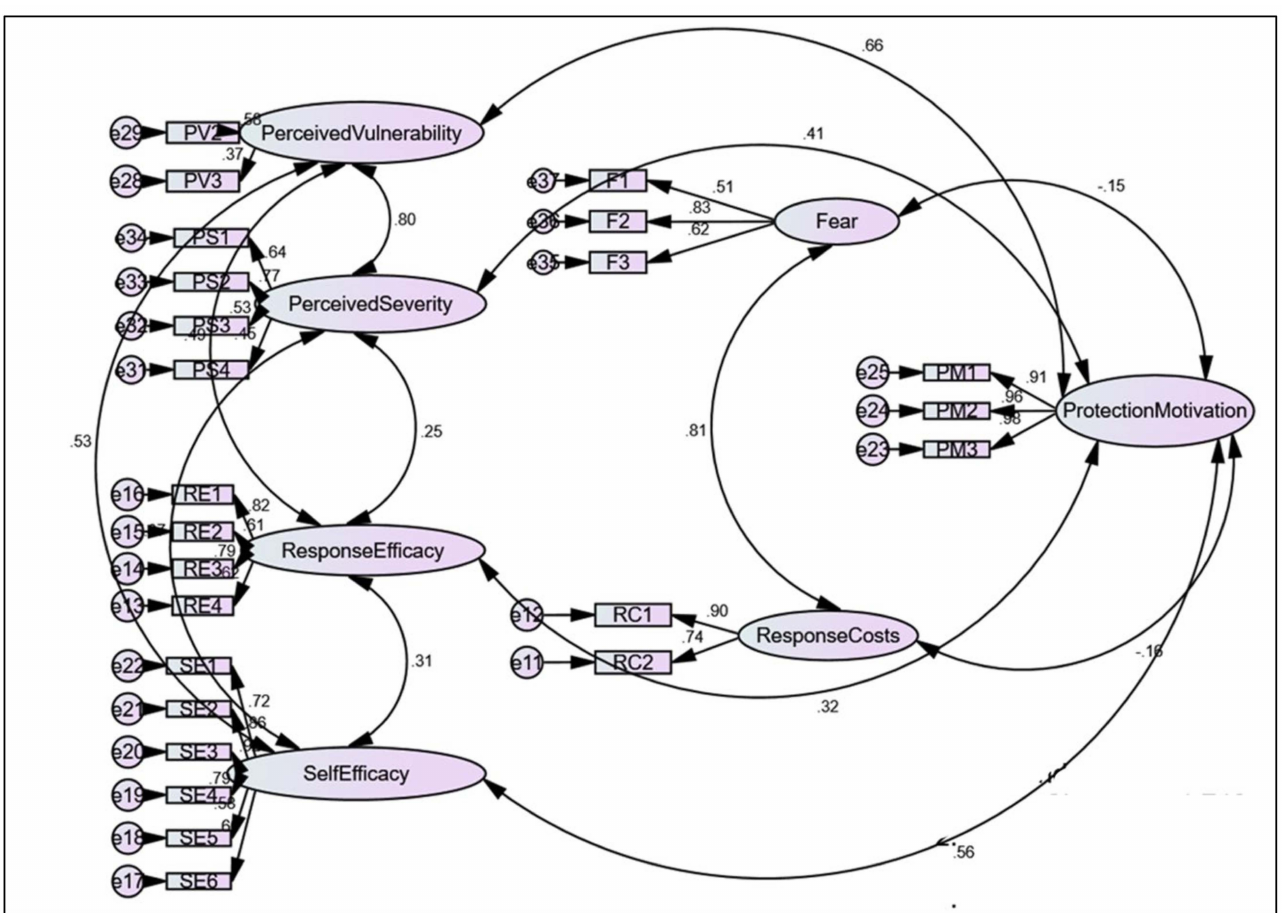
Figure 1. The finalized overview of the confirmatory factor analysis. The circle shape represents the unobserved variables, the rectangle shape represents the observed variables of PMT items (PV = perceived vulnerability, PS = perceived severity, RE = response efficacy, SE = self-efficacy, F = fear, RC = response costs, PM = protection motivation) and the oval shape represents the seven PMT constructs. The double headed arrow shows the correlation between the PMT